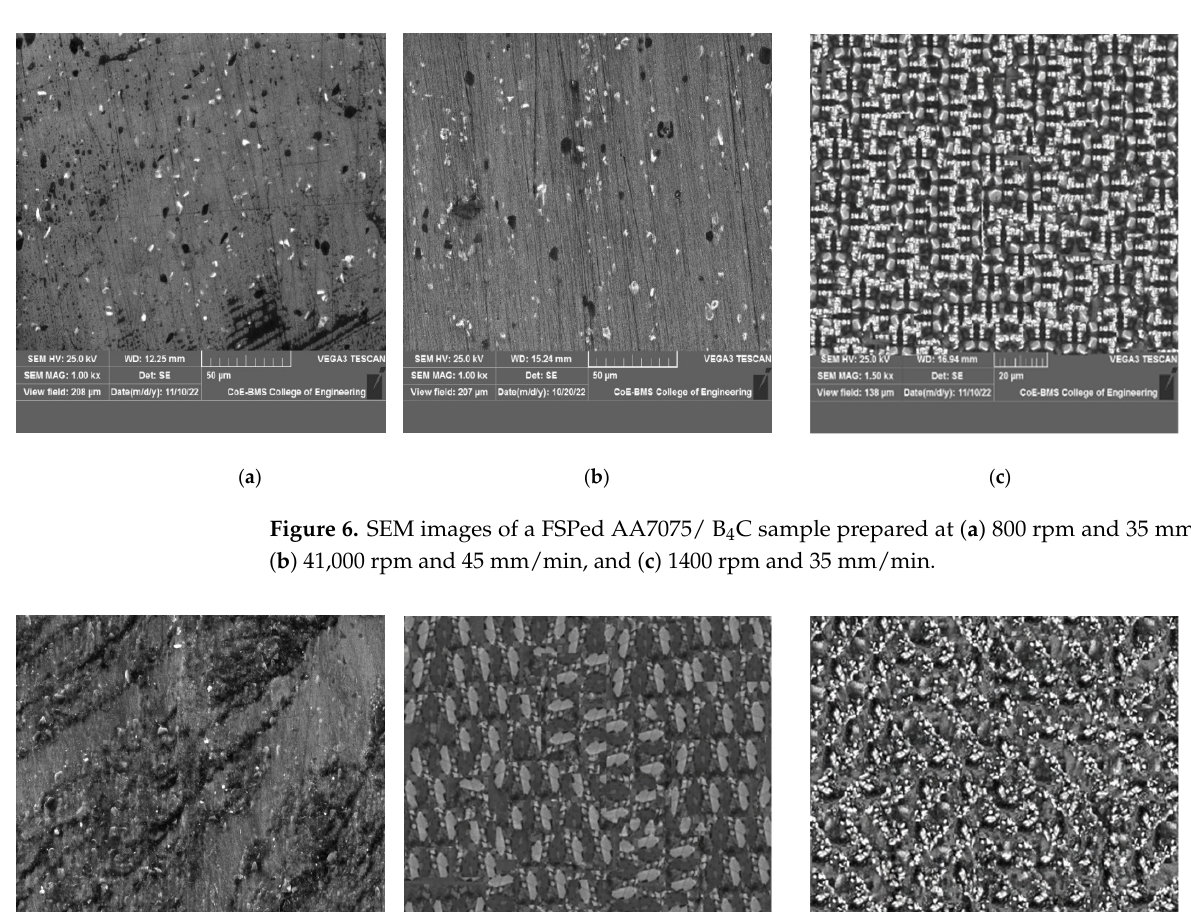
Figure 5. SEM images of a FSPed AA7075/ TiO 2 sample prepared at ( a ) 1400 rpm and 45 mm/min, ( b ) 2000 rpm and 35 mm/min, and ( c ) 2000 rpm and 45 mm/min. SEM images of the FSPed specimens with B 4 C made at feed rates of 25–45 mm/min and rotating speeds of 800–2000 rpm are shown in Figures 6a–c and 7a–c, respectively. The FSPed specimen’s cross-section revealed no flaws or porosities, but there was some aggregation of B 4 Cparticles, proving that the distribution of the particles in the aluminum matrix was not random. There were relatively few faults apparent in the interface, and it appeared that the surface composite layer was extremely effectively bound to the alumi- num alloy AA7075 substrate.